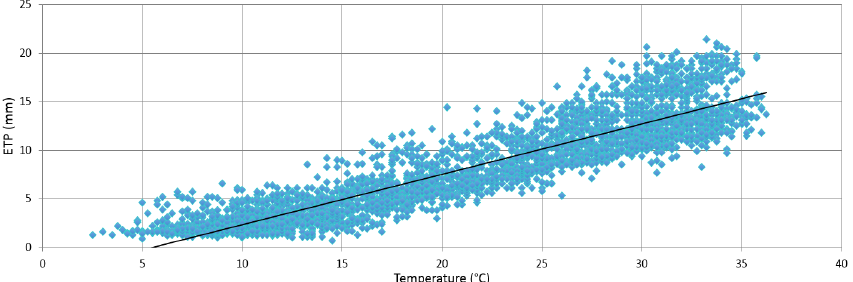
Figure 3. Observed daily mean temperature vs. observed daily potential evapotranspiration (ETP) at the Baba Arab meteorological station for the period from 1 October 2002 through 30 September